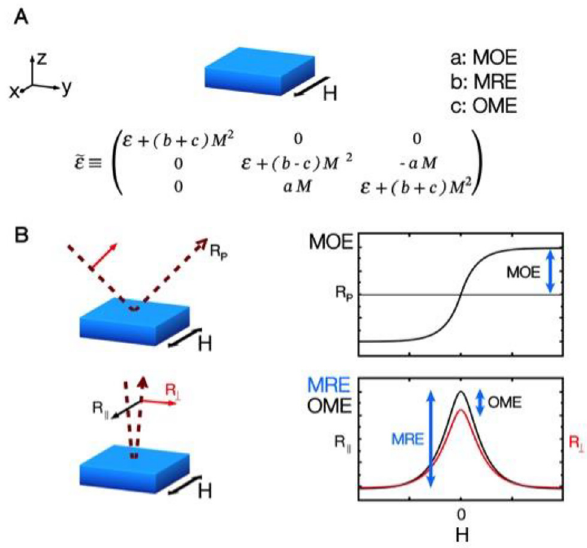
Figure 3: Linear and quadratic dependence of magnetization related optical effects. (A) Dielectric tensor of an isotropic ferromagnetfullymagnetizedalongthe x direction.Mrepresentsthe magnetization,anda,bandcarecoef fi cientsrelatedtotheMagneto Optical(MOE),MagnetoRefractive(MRE)andOrientationalMagneto Optical (OME) effects, respectively. (B) Re fl ectivity vs magnetic fi eld curvesshowingthedifferentmagnetic fi elddependenceofthelinear (OME) and quadratic (MRE, OME) effects,